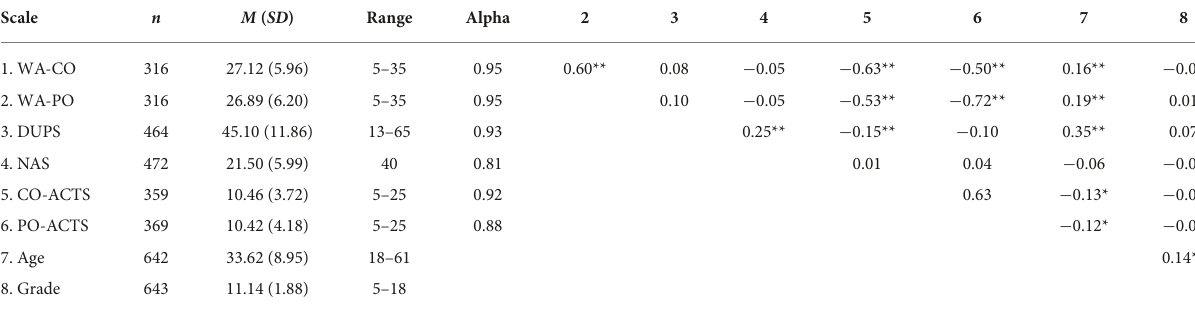
TABLE 1 Descriptive statistics, coefficient alpha, and pearson